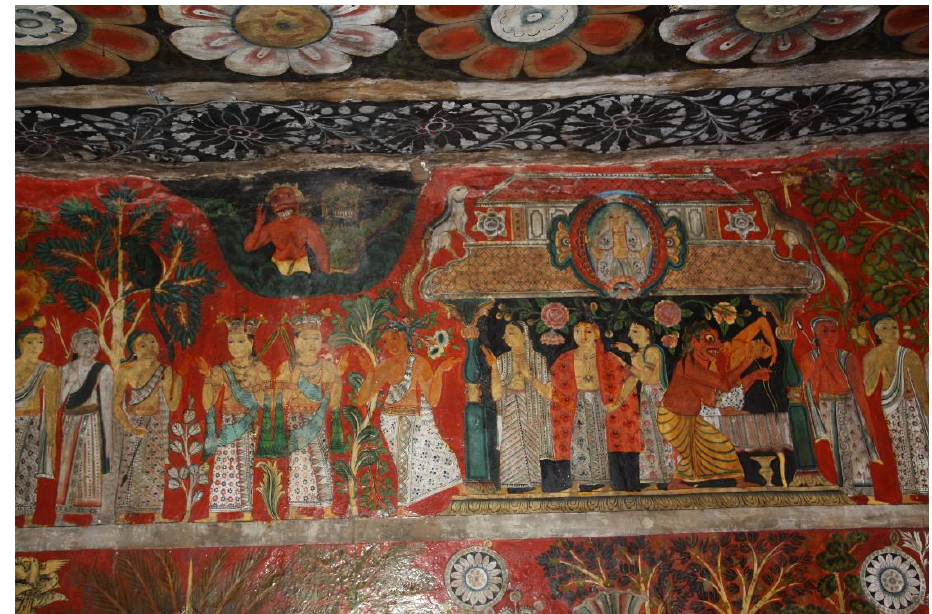
Figure 3. Telapatta Jātaka from Mulkirigala, Sri Lanka, courtesy Osmund